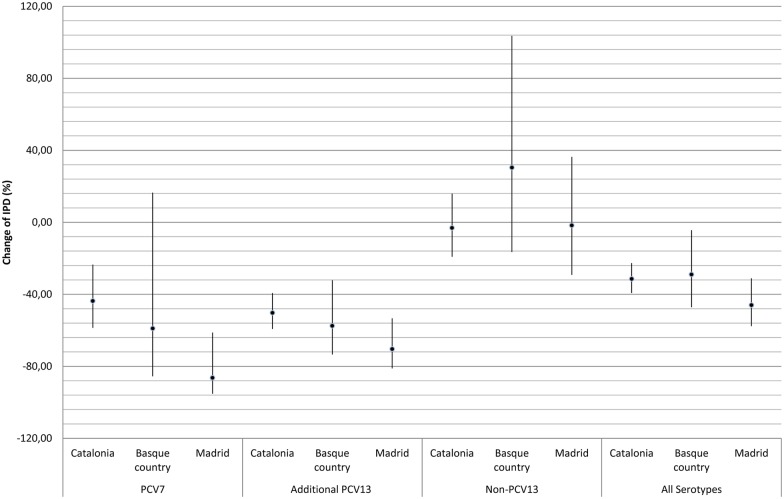
Regional changes in IPD by serotype group.Dots expressed the percentage of change and lines the limits of 95% CI. The decrease of IPD due to PCV7 and PCV13 additional serotypes was more noticeable in Madrid (the only region that included universal children vaccination with PCV13) than in the Basque Country or Catalonia.